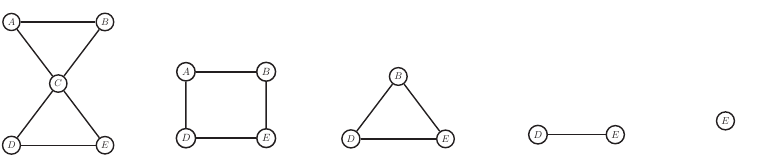
Figure 5. A five vertices graph for finding treewidth by eliminating vertices with the vertex elimination order π = ( C , A , B , D , E ) .